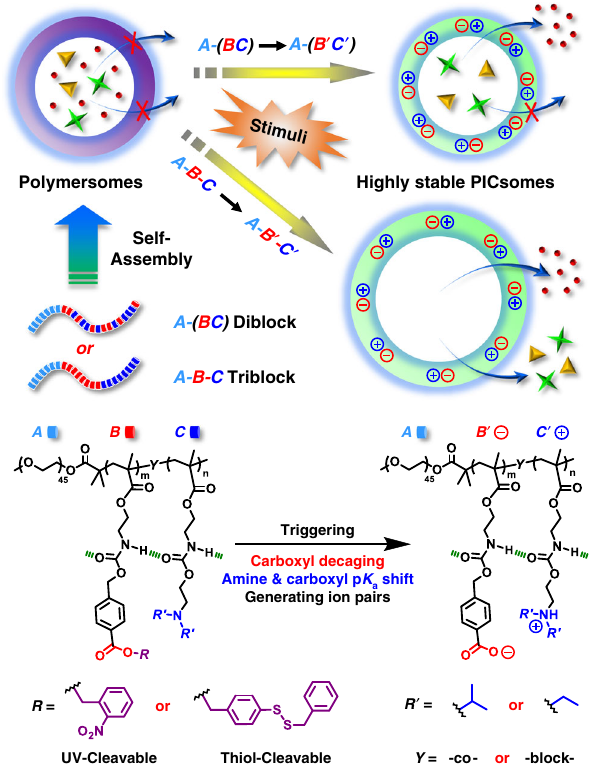
Fig. 1 Stimuli-triggered polymersome-to-PICsome transition and concurrent permeability regulation. For polymersomes self-assembled from amphiphilic diblock and triblock copolymers containing tertiary amine and caged carboxyl moieties in the hydrophobic block, external stimuli including UV light and reductive milieu trigger the decaging of carboxyl functionalities, which transfer protons onto neighboring tertiary amine moieties and render ion-pair interactions. Note that in situ generated PICsomes are highly stable towards extreme pH range, high ionic strength, and elevated temperature due to cooperative ion-pair interactions at high local concentration within pre-organized vesicle bilayers and synergistic contributions from hydrogen bonding interactions of carbamate side linkages. The polymersome-to-PICsome transition is accompanied with the transformation of hydrophobic bilayers into semipermeable membranes and switching of vesicle bilayer permeability. Moreover, sequence structure of the bilayer forming block, A - (B- co -C) vs. A-B-C, could be further utilized to regulate the permselectivity of resultant semipermeable PICsome